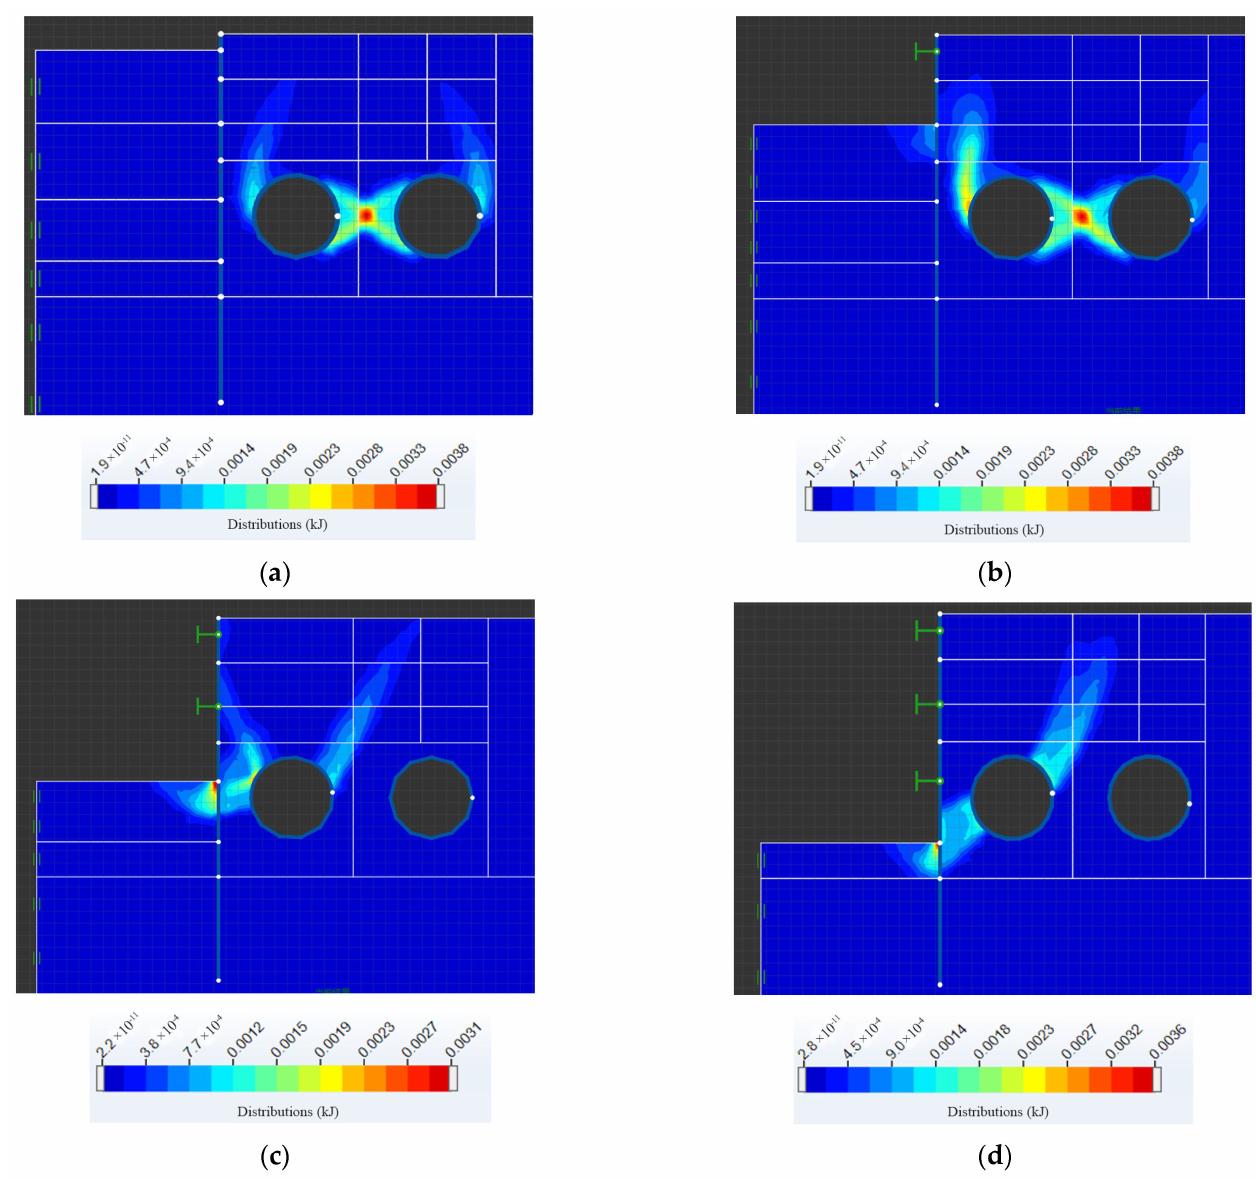
Figure 9. Shear dissipation contours under each stage: ( a ) Stage (1) ( h = 0.08 H), ( b ) Stage (2) ( h = 0.4 H), ( c ) Stage (3) ( h = 0.75 H) and ( d ) Stage (4) ( h = 1.0 H). In Figure 11, the different colors of the axial force diagram represent the value of the axial force. The absolute value of the axial force is larger when the color of the shear dissipation contours is more approximate to blue. As can be seen from Figure 11, axial force of the enclosure structure in each stage increases with the increase in excavation depth. The axial force of enclosure structure in stage 1 and stage 2 is mainly affected by twin shield tunnels. From the beginning of stage 3, the axial force is greatly influenced by the excavation itself, and the position of the extreme value of axial force gradually progresses downward. The maximum axial force occurs in stage